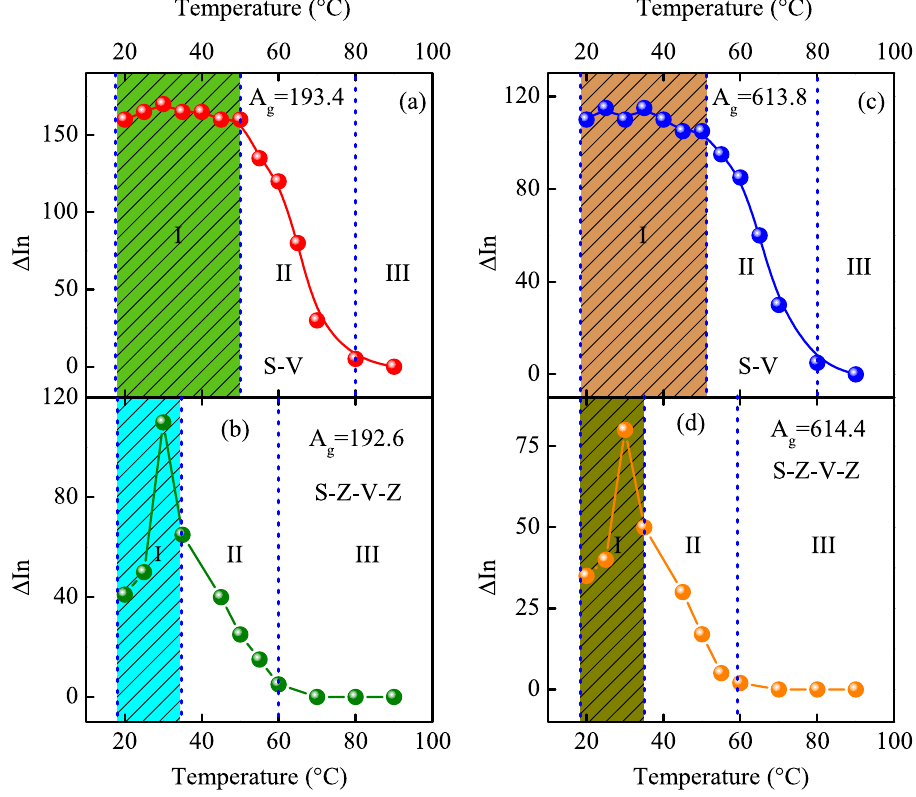
Figure 6. ( a – d ) The temperature-dependent relative Raman intensity for S-V and S-Z-V-Z, respectively. The Raman intensity of S-V follows the traditional behavior while S-Z-V-Z presents the abnormal